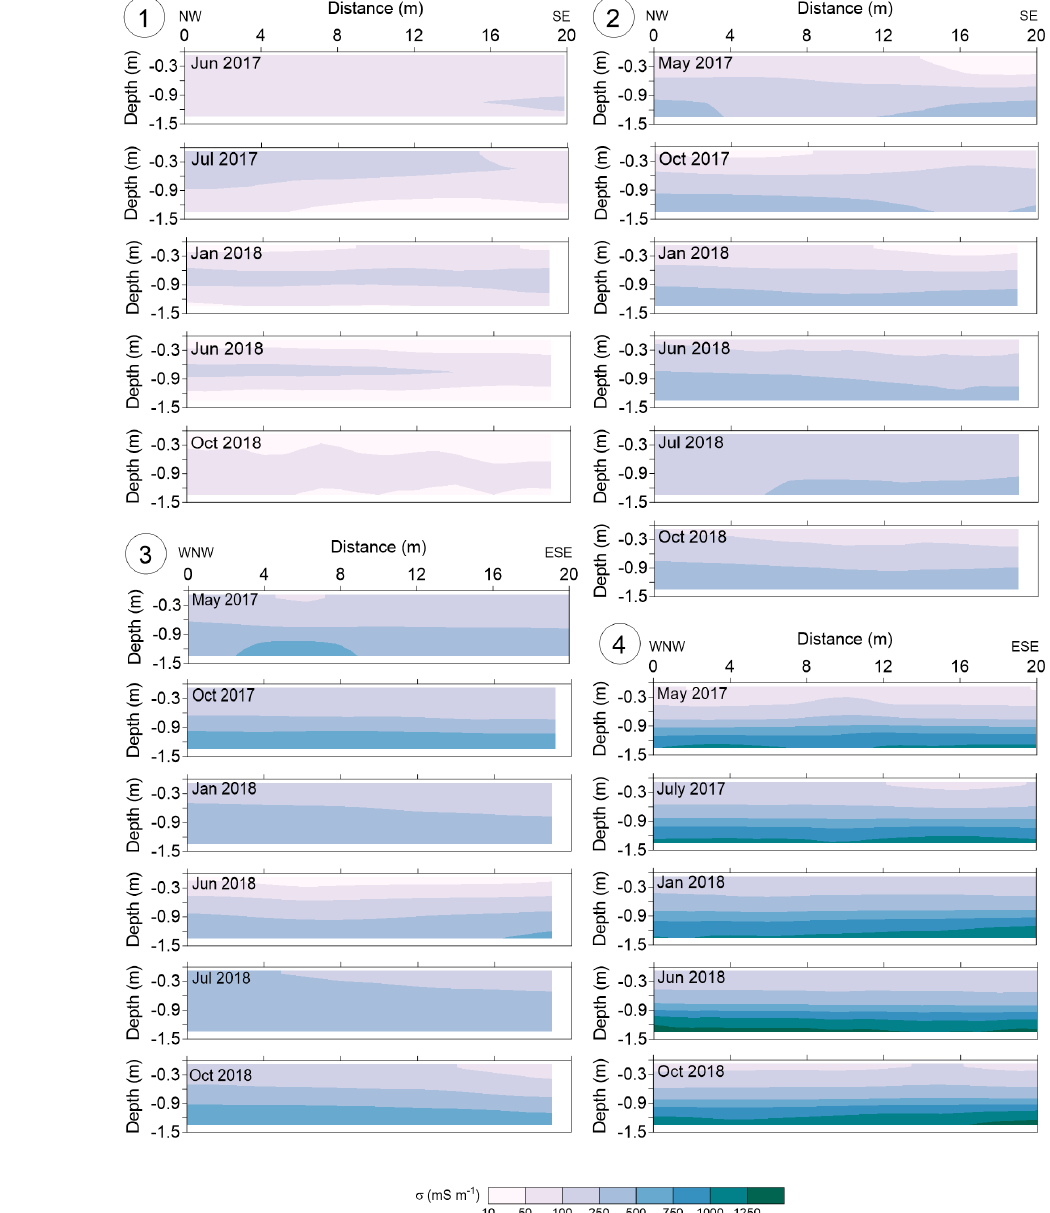
Figure 4. Time-lapse electromagnetic conductivity images (EMCIs) for locations 1 to